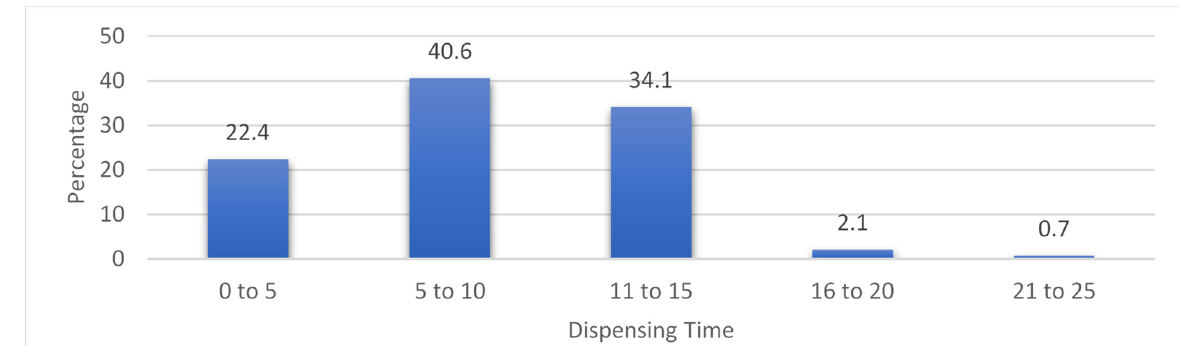
Figure 4. Percentage of dispensing